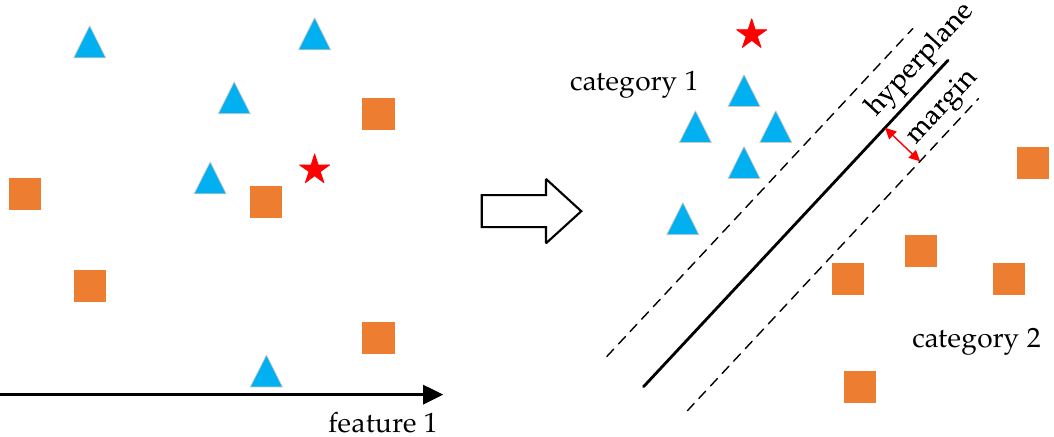
Figure 12. Support vector machine classification presented in 2-dimensional form.